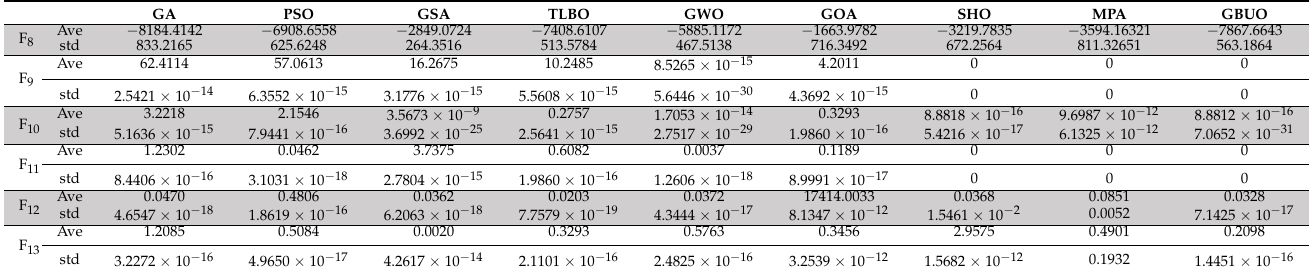
Table 4. Results of applying optimization algorithms on multimodal objective functions.